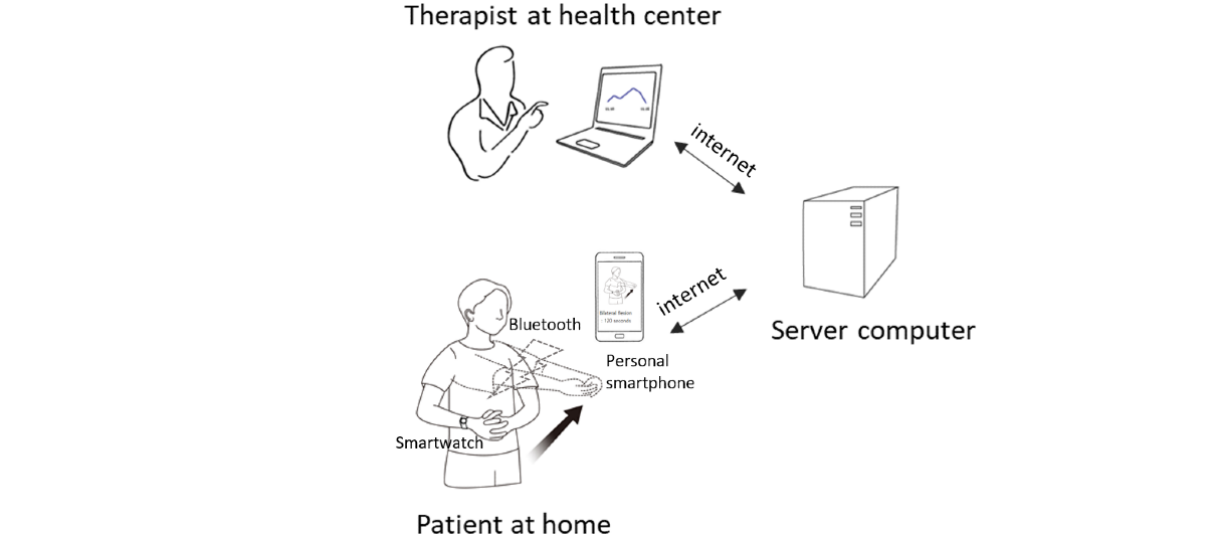
Figure 1. Overview of the home-based rehabilitation system.